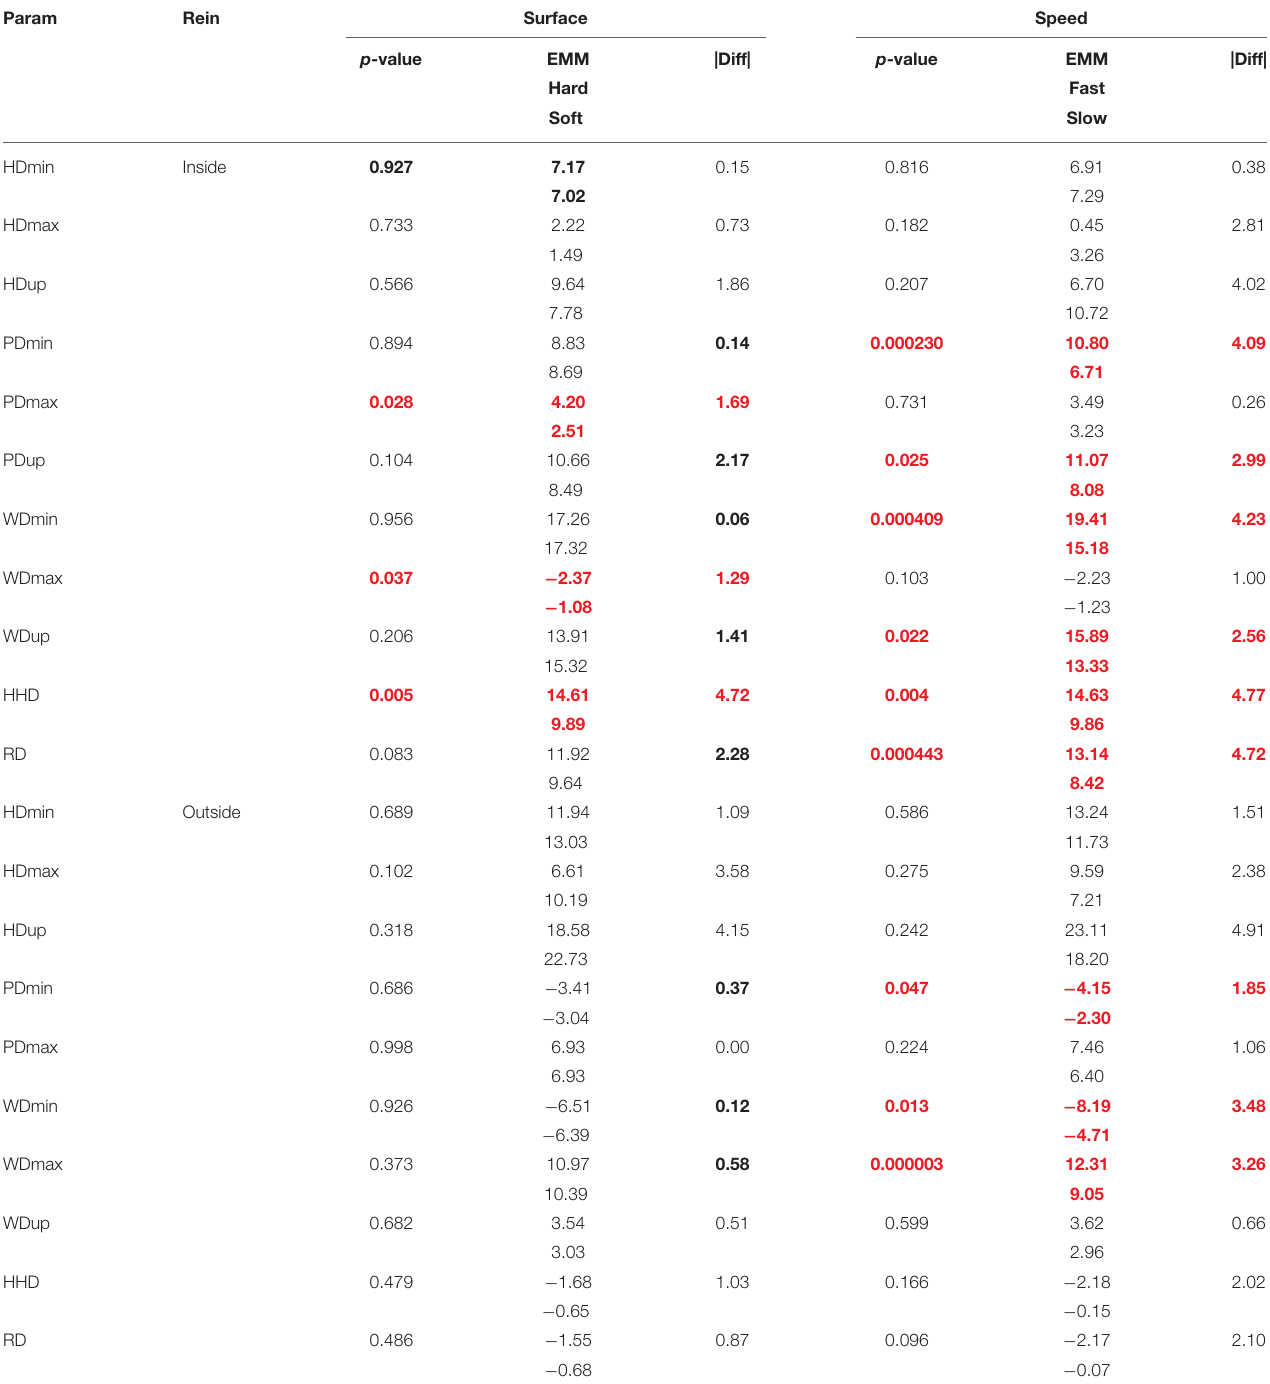
TABLE 5 | p -values and estimated marginal means for 22 mixed linear models for 11 normalized movement asymmetry parameters: one model for each rein (inside/outside). Param